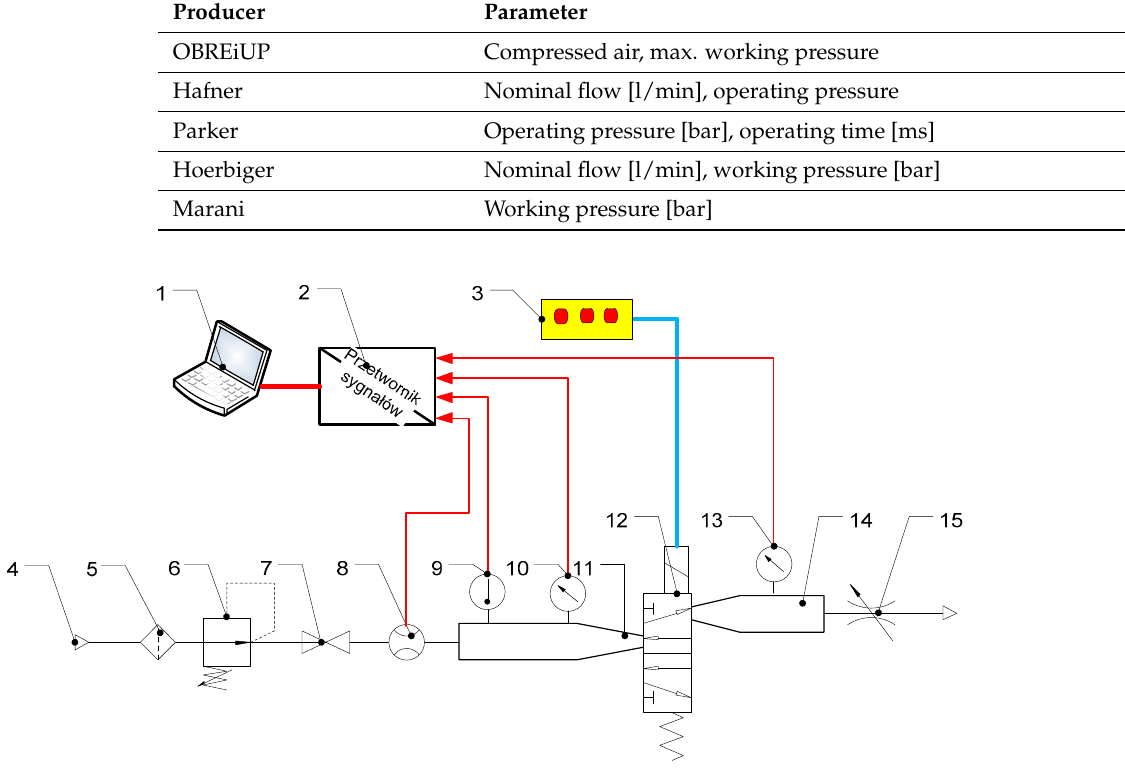
Figure 4. Diagram of the measuring stand: 1—computer, 2—recorder of signals from measuring sensors, 3—control panel, 4—compressed air, 5—filter, 6—reduction valve, 7—source cut-off valve, 8—flow meter, 9—temperature sensor, 10—pressure sensor, 11—measuring tube, 12—tested valve, 13—pressure sensor, 14—measuring tube at the outlet from the tested element, 15—throttle valve.